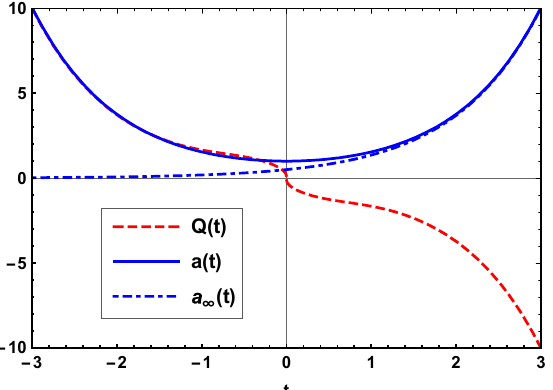
Figure 9. Time evolution of a ( t ) = cosh ( γ t ) (solid line) and its corresponding quantum potential (49) (dashed line), for k = a 0 = γ = 1. The notation a ∞ ( t ) represents the asymptotic form of a , a ∞ ( t ) = 1 (dash-dotted line), which is equivalent to Solution